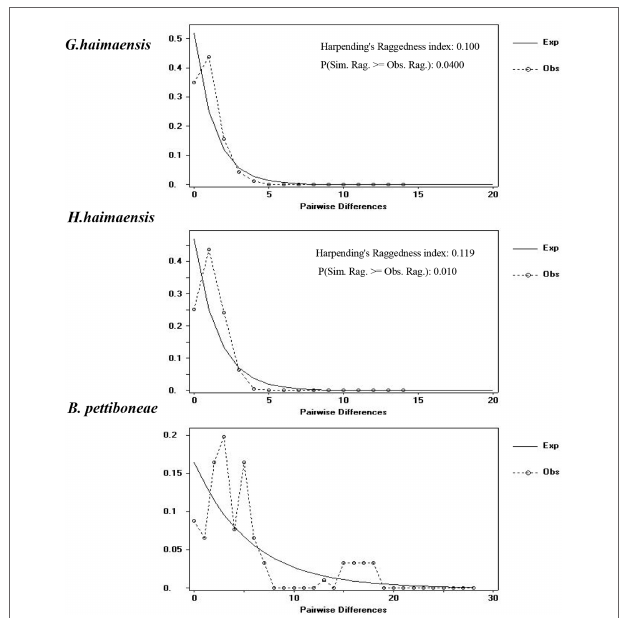
FIGURE 3 | Observed (broken lines) and expected (solid lines) mismatch distribution for three representative macrobenthos species basing on COI sequence. X-axis = pairwise differences and Y-axis =